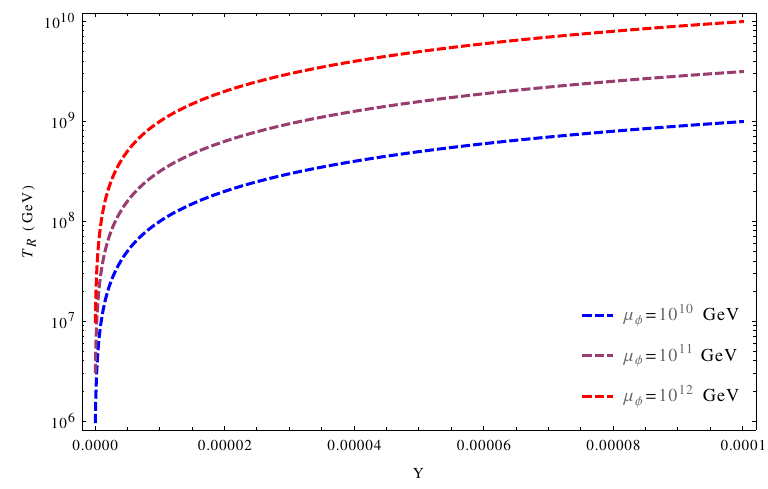
Figure 3 . Reheating temperature T R versus the Yukawa coupling Y for di(cid:11)erent values of the in(cid:13)aton mass parameter (cid:22) (cid:30) = 10 10 ; 10 11 ; 10 12